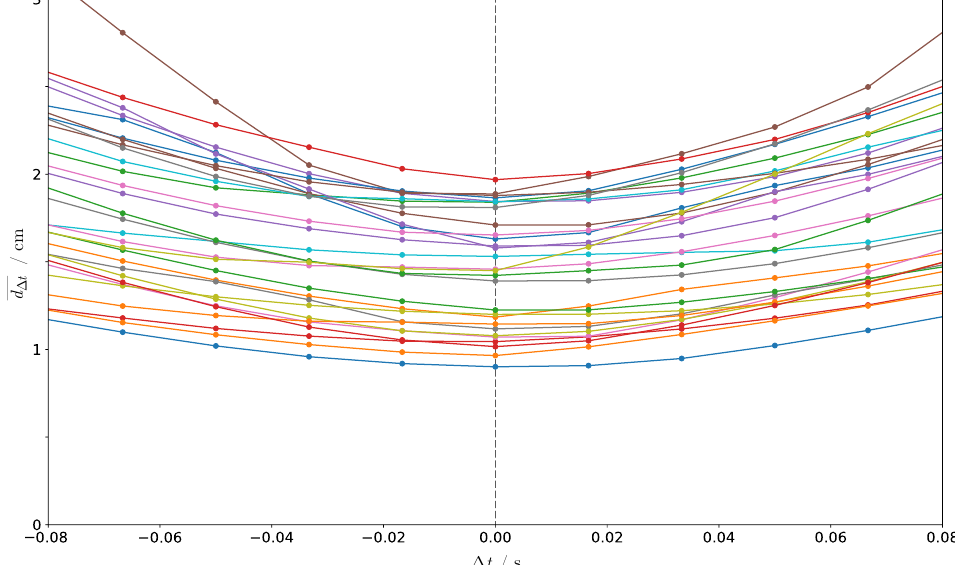
Figure 5. Average distance d ∆ t between the original camera trajectory and the corresponding trajec- tory from HTS when shifting the IMU data by ∆ t around the minimum at correct time t = 0 (known for these experiments). Each line represents an other experimental run and thus an independent fusion